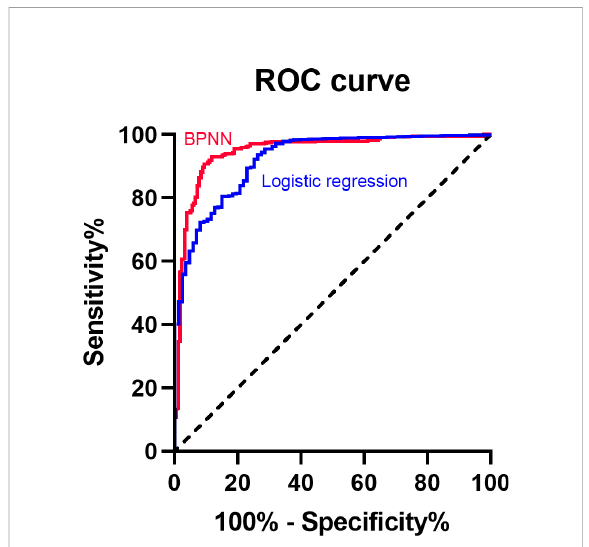
FIGURE 2 ROC curve of BPNN and multivariate logistic regression model. BPNN, back propagation neural network; ROC, receiver operating characteristic